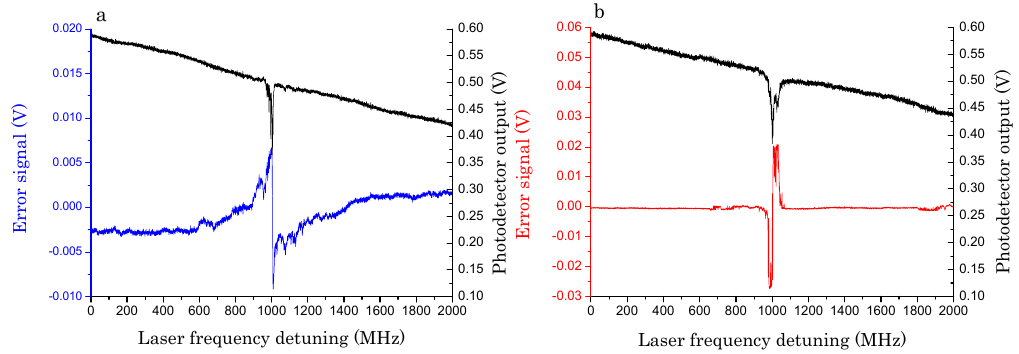
Figure 7. WGM resonance along a laser frequency sweep on the directly-transmitted beam (black line) and the corresponding error signal generated by ( a ) spatial interference on the back-scattered light (blue line) and ( b ) Pound–Drever–Hall technique (red line) (All plots are reproduced with permission plots from [41]).